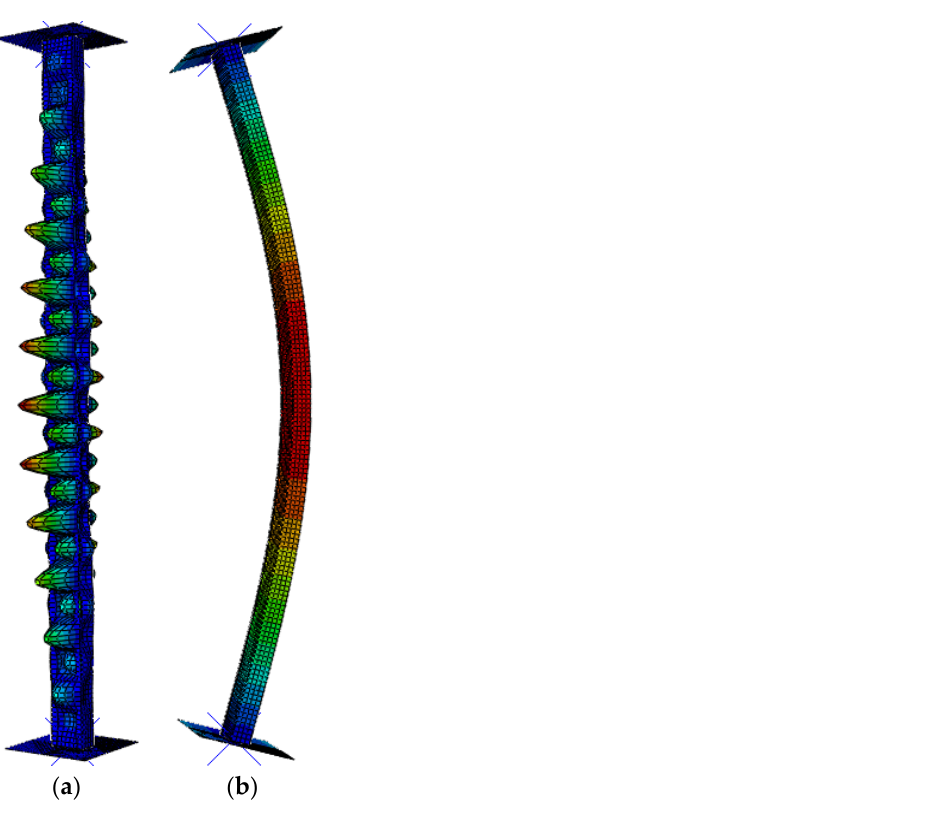
Figure 4. Initial geometric buckling modes for BL-L500-t1-S5: ( a ) local buckling; and ( b ) overall buckling.